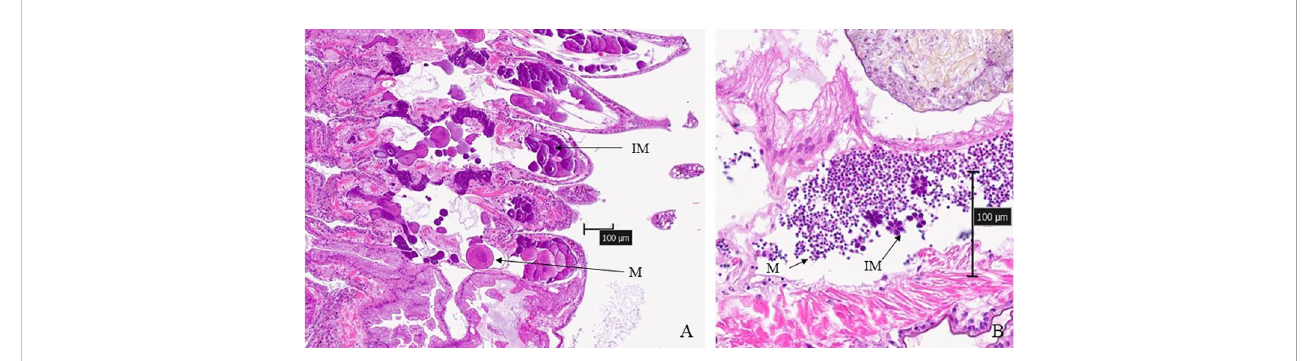
FIGURE 4 Histological section of (A) 21-mm-long female and (B) 25-mm-long male. IM, immature gametes; M, mature/maturing gametes. Scale bar, 100